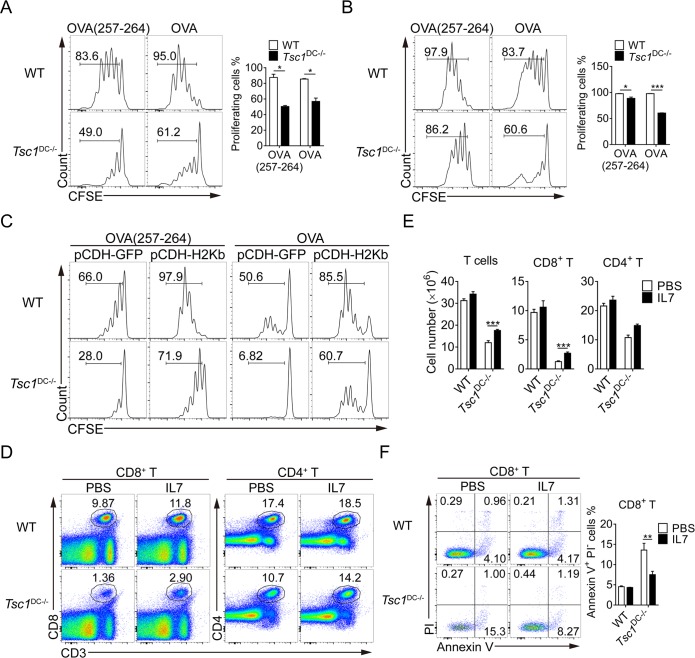
Exogenous MHC-I and IL-7 can rescue CD8+ T-cell defects in TSC1DC-KO mice.(A and B) WT and TSC1DC-KO BMDCs (A) or spleen DCs (B) pulsed with 0.1 ng/ml OVA257-264 or 0.25 mg/ml OVA for 1 hour and 6 hours, respectively, were cocultured with CFSE-labeled purified OT-I CD8+ T cells for 3 days. The proliferation of OT-I CD8+ T cells was analyzed by division of CFSE by flow cytometry. This experiment was repeated three times with similar results. The data are presented as means ± SEM (*p < 0.05, ***p < 0.001; analyzed by Student’s t test). (C) Control (pCDH-GFP) and H2-Kb expressing (pCDH-H2-Kb) lentiviruses vectors were transfected into BMDCs, and GFP+ DCs were sorted. Transfected BMDCs were then pulsed with 0.1 ng/ml OVA257-264 or 0.25 mg/ml OVA for 1 hour and 6 hours, respectively, and cocultured with CFSE-labeled OT-I CD8+ T cells for 3 days. Cell proliferation indicated by division of CFSE was assessed by flow cytometry. This experiment was repeated once with similar results. (D–F) The 6–8-week-old WT and TSC1DC-KO littermates (n = 6) were i.p. injected with PBS or IL-7 (10 μg/kg) for 5 days. The percentages (D), cell numbers (E), and apoptotic ratios (F) were analyzed by flow cytometry, respectively. These experiments were repeated twice with similar results. The data are presented as means ± SEM (**p < 0.01, ***p < 0.001; analyzed by Student’s t test). Underlying data are available in S1 Data. BMDC, bone marrow–derived DC; CD, cluster of differentiation; CFSE, carboxyfluorescein diacetate succinimidyl ester; DC, dendritic cell; GFP, green fluorescent protein; H2-Kb, histocompatibility 2, K1, K region; i.p., intraperitoneally; IL, interleukin; MHC, major histocompatibility complex; OT, ovalbumin-specific TCR transgenic mouse; OVA, ovalbumin; PBS, phosphate-buffered saline; PI, propidium iodide; Tsc1, tuberous sclerosis complex subunit 1; TSC1DC-KO, specific ablation of Tsc1 in the DC compartment; WT, wild-type.